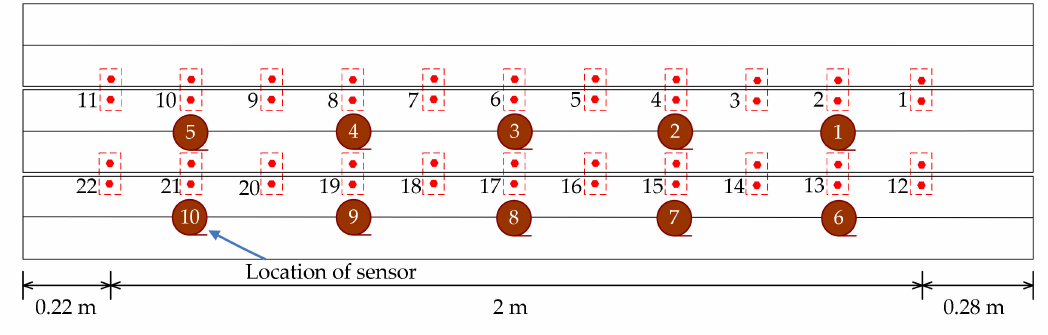
Figure 3. Arrangementoftheaccelerometersandthedevicessimulatingdamageinthetransverseconnections.